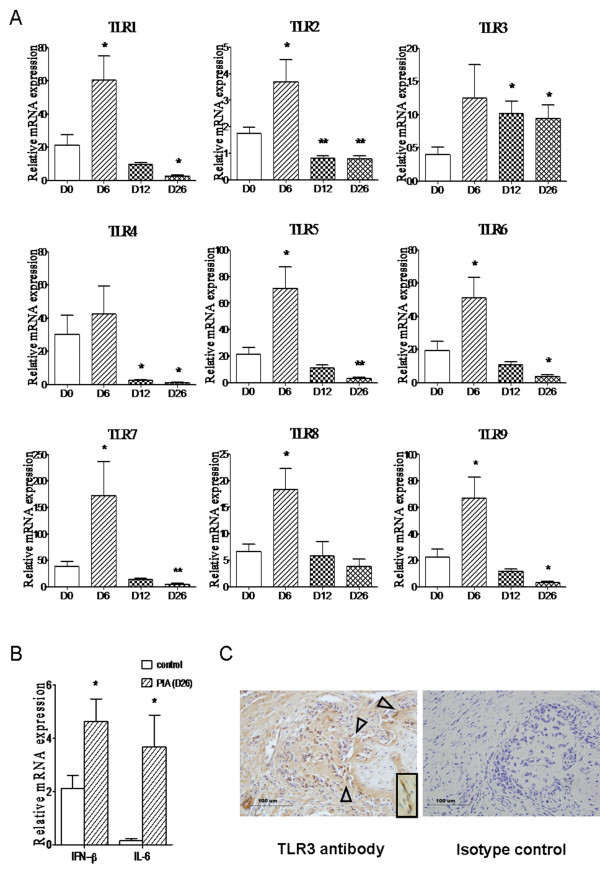
Expression of Toll-like receptors in synovium from Dark Agouti rats with pristane-induced arthritis. (A) Expression of TLR1 through TLR9 at D0, D6, D12 and D26, and (B) expression of IFN-β and IL-6 at D0 and D26 in synovium from rats (n = 8 to 10 for each time point) after pristane injection were measured by performing real-time PCR. Relative mRNA expression was compared with β-actin. Values shown are means ± SEM. Levels of significance between the pristane treatment group (D6, D12 and D26) and the control group (D0) were calculated by using Student's t-test (*P < 0.05, **P < 0.01). (C) TLR3 protein was assessed by performing immunohistochemistry in pristane-induced arthritis (PIA) synovium. TLR3 was strongly stained (brown, left-hand image) in synovium, especially in fibroblast-like synoviocytes (FLSs) (inset). FLSs from PIA joints expressed TLR3 predominantly at sites of attachment and invasion into cartilage and bone (open arrowheads). Staining specificity was assessed using isotype-matched antibodies as negative controls (right-hand image). Scale bars, 100 μm.